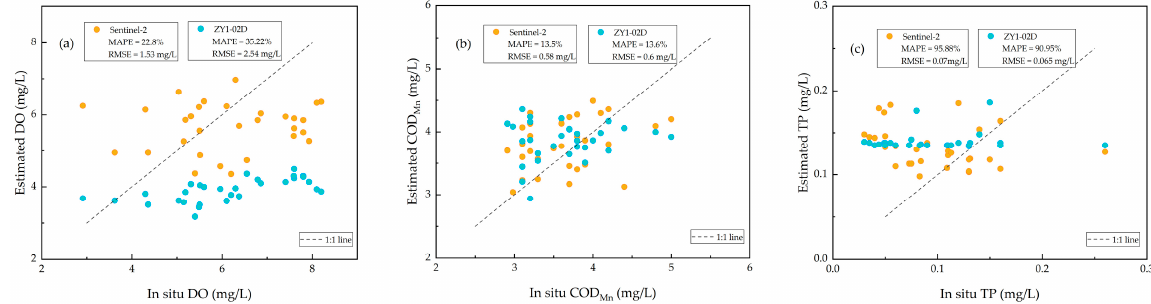
Figure 17. Comparison between images derived and Dataset 2 DO ( a ), COD Mn ( b ), and TP ( c ).